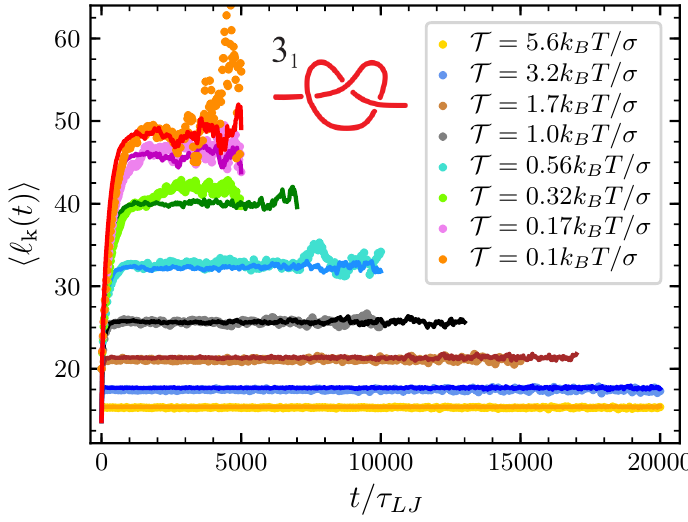
considered as a function of T